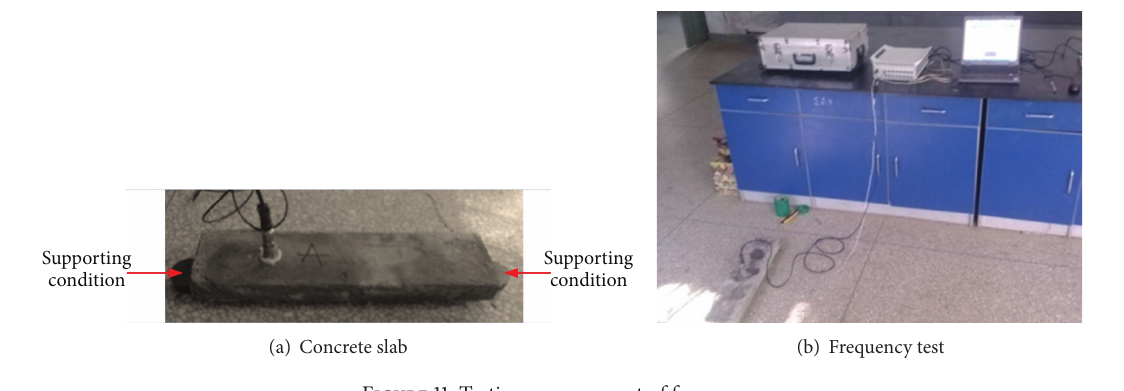
Figure 11: Testing arrangement of frequency.